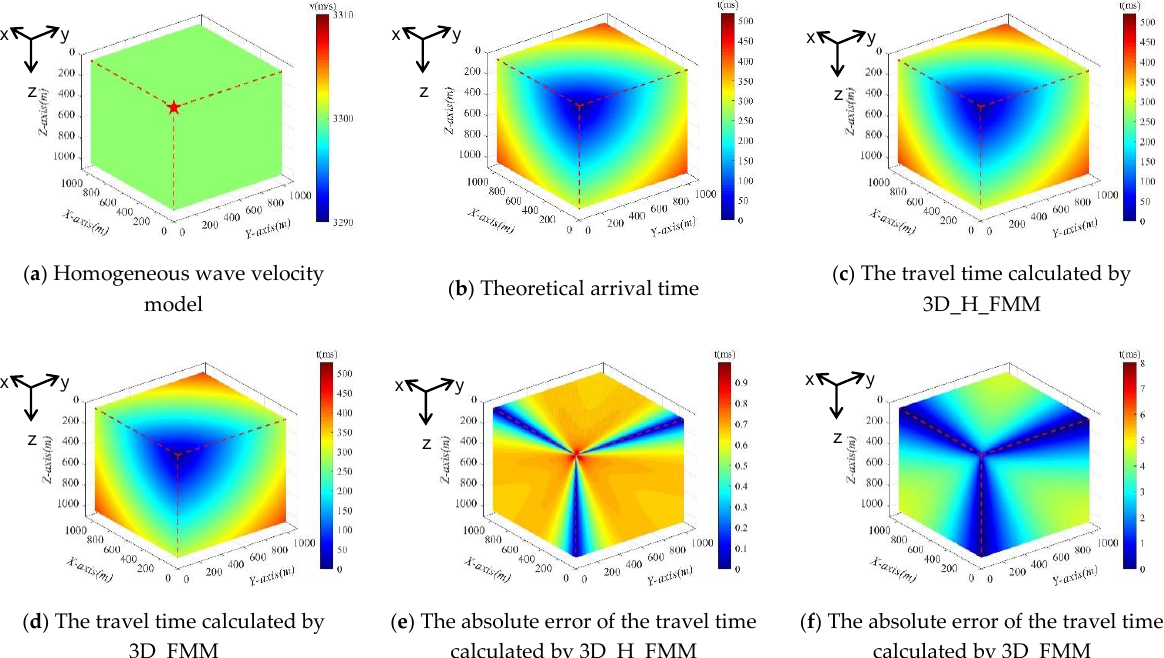
Figure 8. The Case B: large-scaled homogeneous model and its theoretical arrival time, the P-wave travel time, and error distribution map calculated by 3D_H_FMM and 3D_FMM.